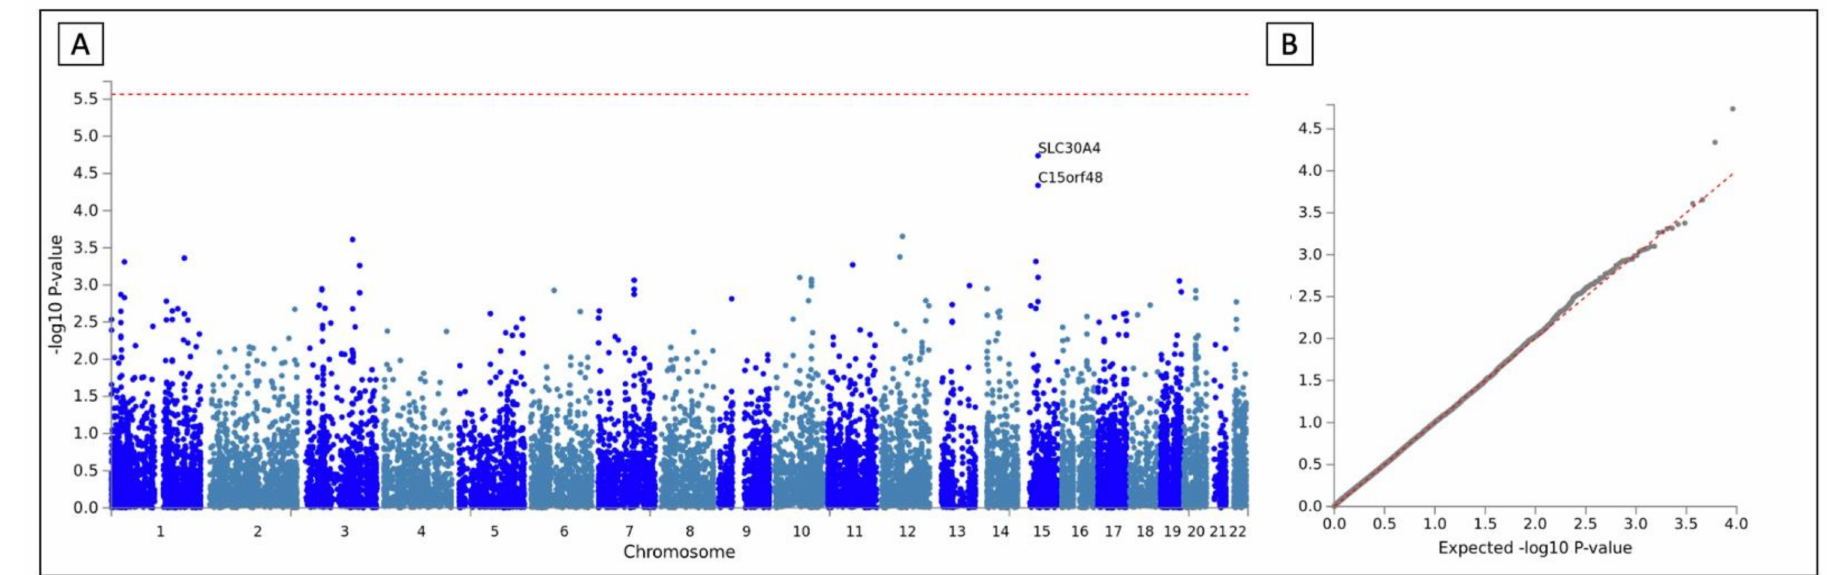
Figure 3. Manhattan and QQ plot of the gene-based meta-analysis. ( A ) Manhattan plot. Genes were represented by dots and plotted based on their p -values. Red line shows the considered significant p -value ( p < 5 × 10 − 8 ). ( B ) QQ plot of the p -values obtained after the association testing. The x-axis represents the expected − log 10 — p -value under the null hypothesis and lambda is the median of the resulting chi-squared test statistics divided by the expected median of the chi-squared distribution under the null